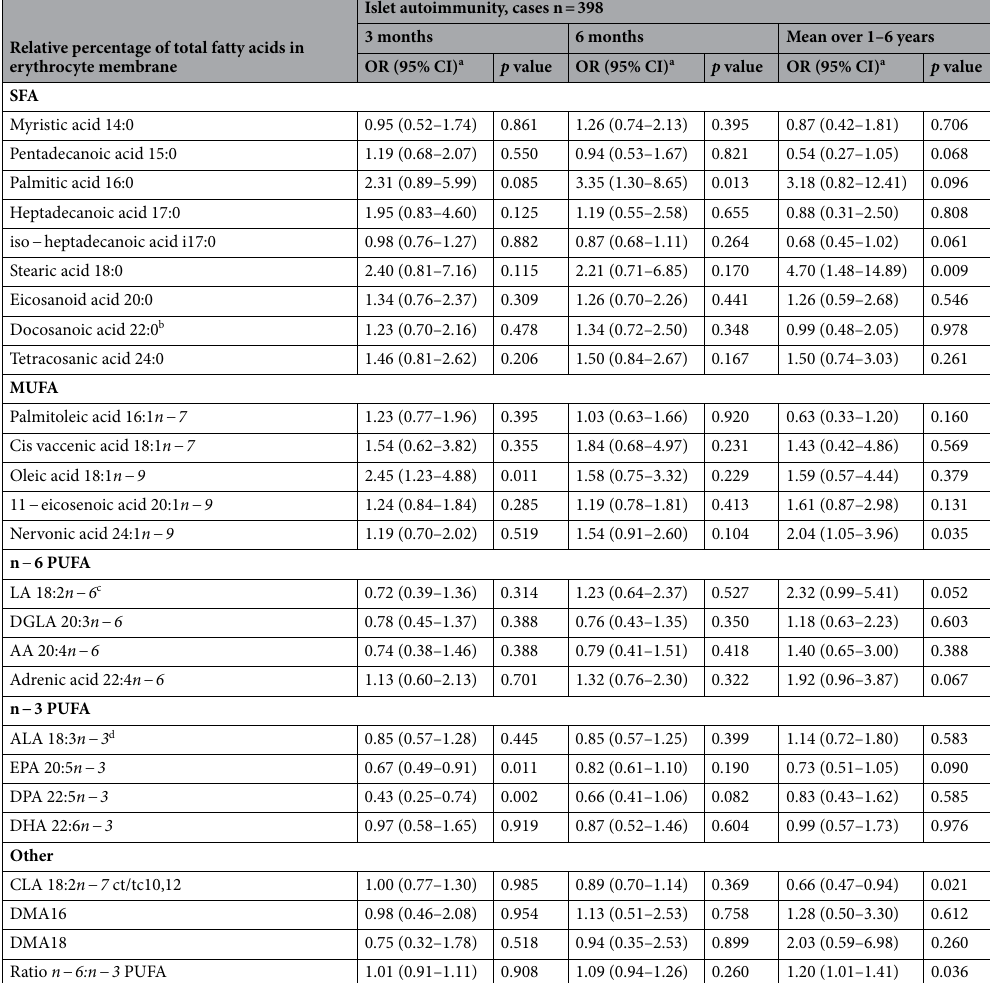
Table 2. The risk of islet autoimmunity associated with erythrocyte fatty acid status in TEDDY nested case– control study. a Conditional logistic regression analysis with centered log-ratio transformed variables (except for the ratio of sum n − 6 and sum n − 3) was adjusted for HLA genotype DR3/4, ancestry (PC1 and PC2), and weight z-score. b Docosanoid acid (22:0) showed interaction with breastfeeding at 3 months of age ( p = 0.027). c LA showed interaction with any breastfeeding at 3 months of age ( p = 0.038). d ALA showed interaction with any breastfeeding at 3 months of age ( p =